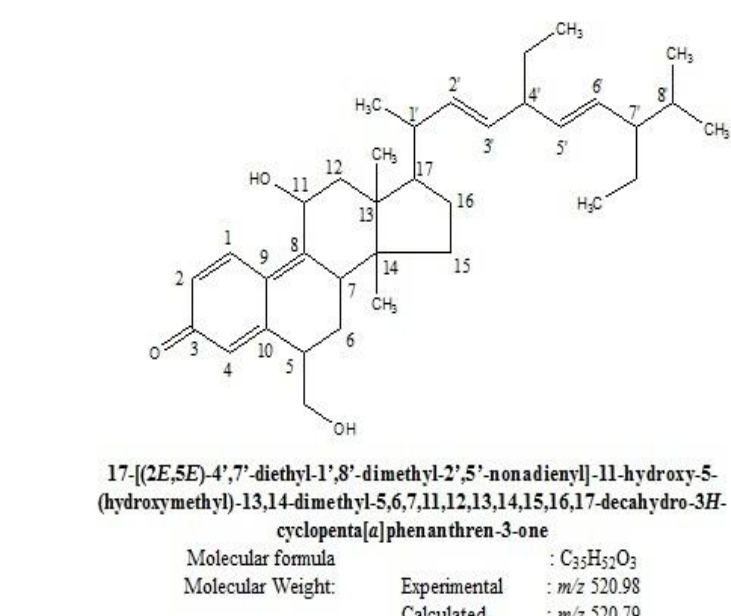
Figure 1. Structures of the novel compounds ( a ) 2879/CHE/2012(cpd-1); ( b ) 2880/CHE/2012(cpd-2); ( c ) 2881/CHE/2012(cpd-3).